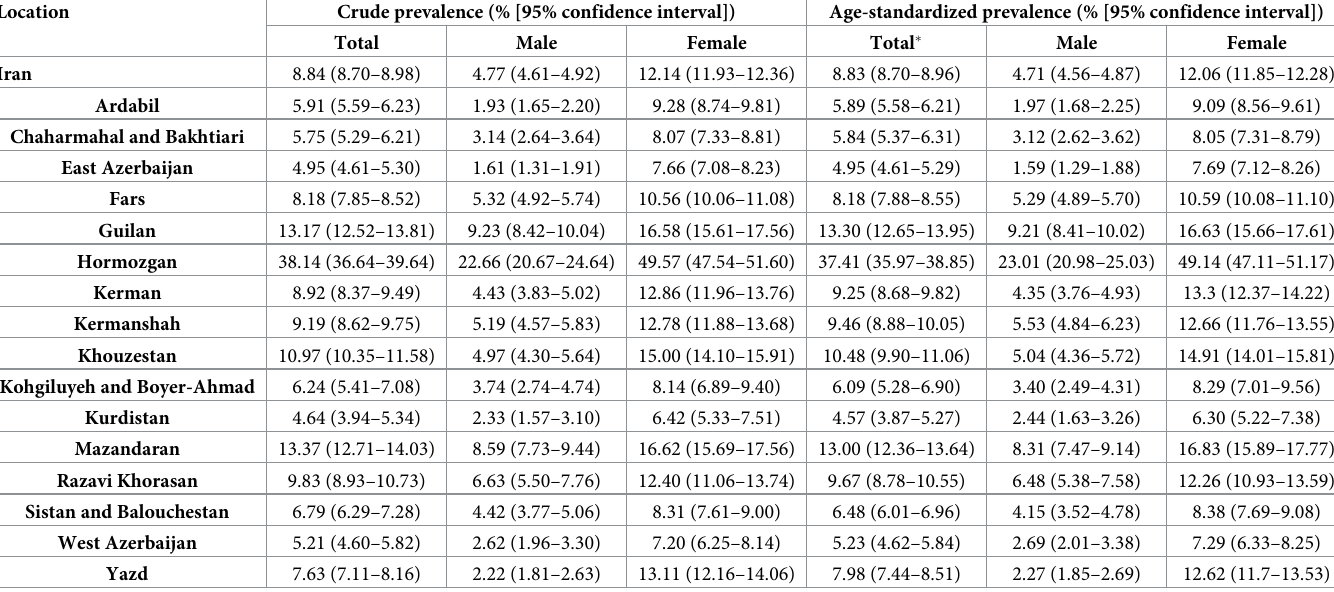
Table 2. Total and sex-specific crude and age-standardized prevalence of anemia by location.